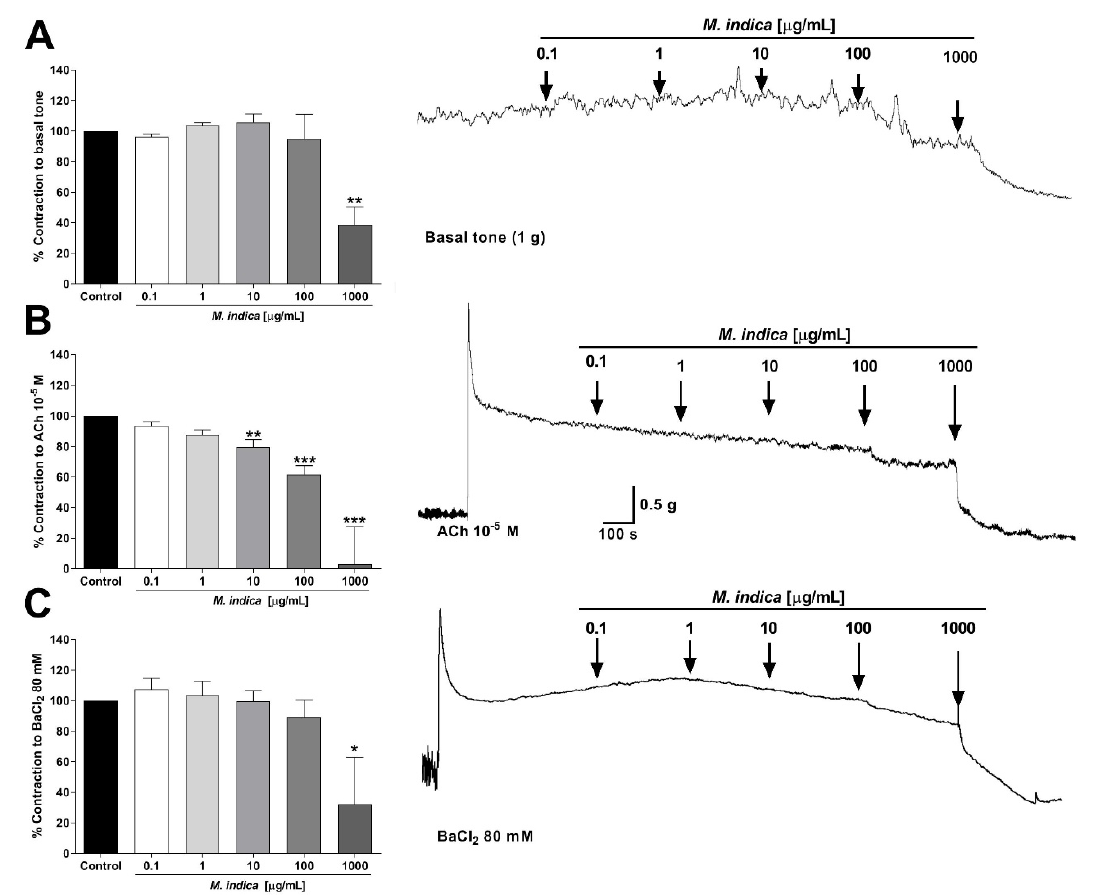
Figure 3. Spasmolytic activity of lyophilized extract of M. indica (MIE) in rat ileum. MIE generated a relaxation on the basal tone in ileal segments ( A ), MIE relaxed ileal segments pre-contracted with 10 − 5 M acetylcholine (ACh) ( B ), or 80 mM BaCl 2 ( C ). In panel ( A ), control represents the basal tone (as 100% of contraction) without any treatment. In panels ( B , C ), control represents the maximum response (100%) induced by ACh and BaCl 2 , respectively. In addition, the original records of the relaxation effects of MIE in rat ileum are shown on the right side. Each bar represents the mean of response in percentage ± SEM of three experiments ( n = 3). * p < 0.05; ** p < 0.01; *** p < 0.001 vs. control.